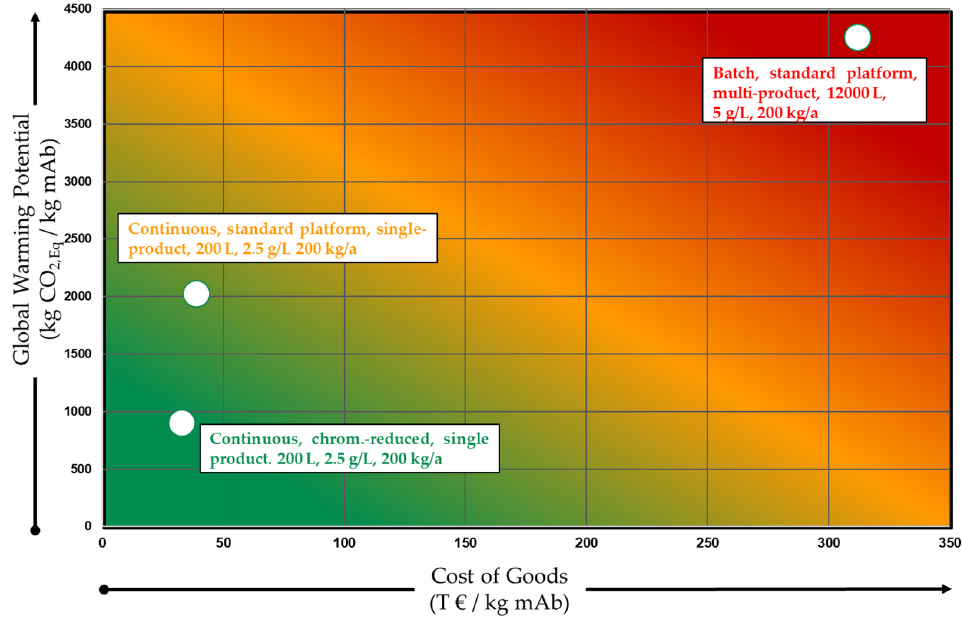
Figure 3. Biologicals GWP (global warming potential) vs. COG (cost of goods) portfolio. mAb: monoclonal antibody.